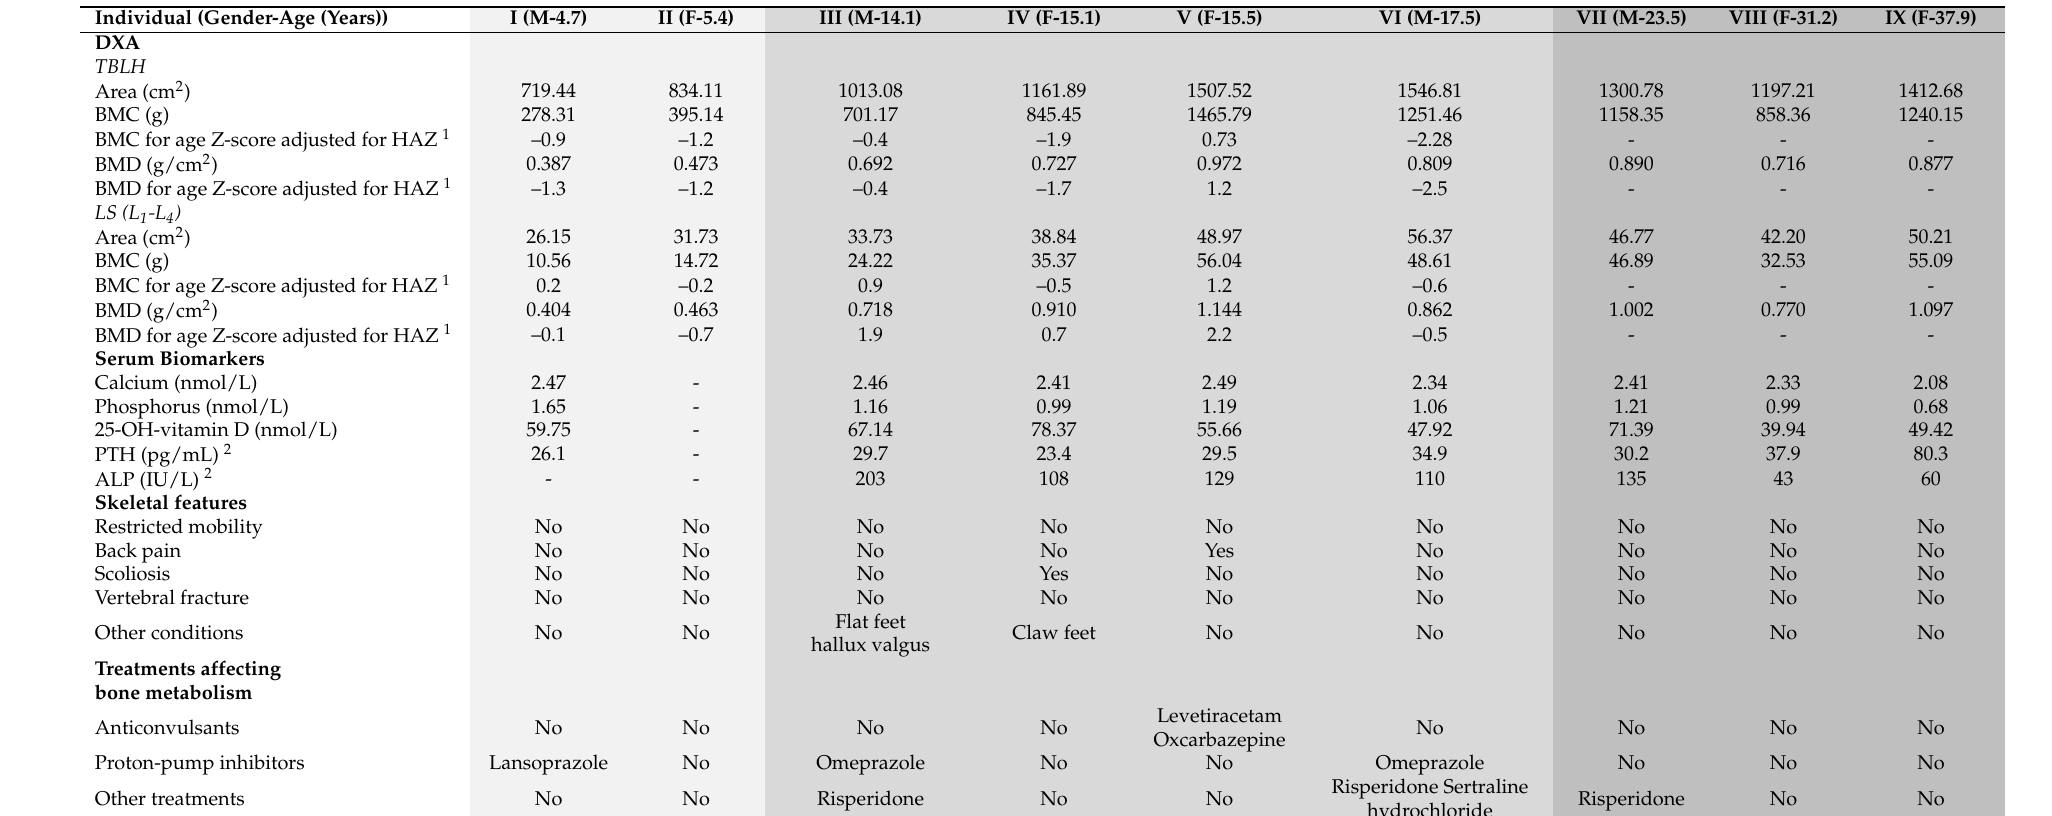
Table 3. Bone health parameters of study